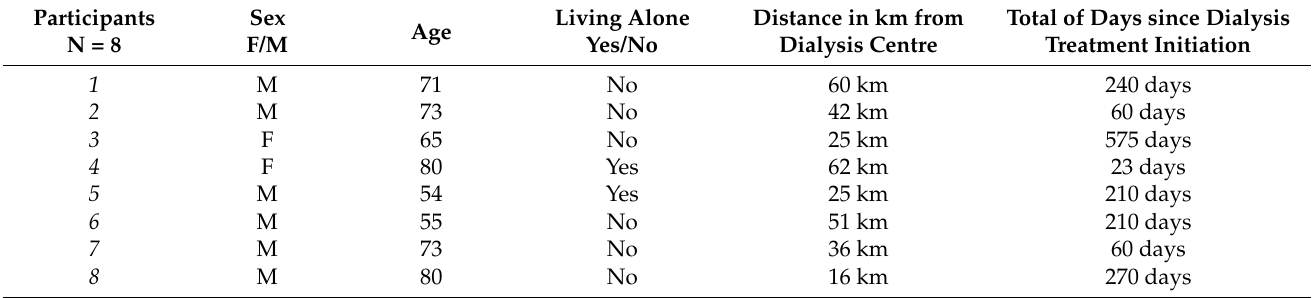
Table 1. Demographics of patients participating in a study on patient preferences in relation to initiation of dialysis